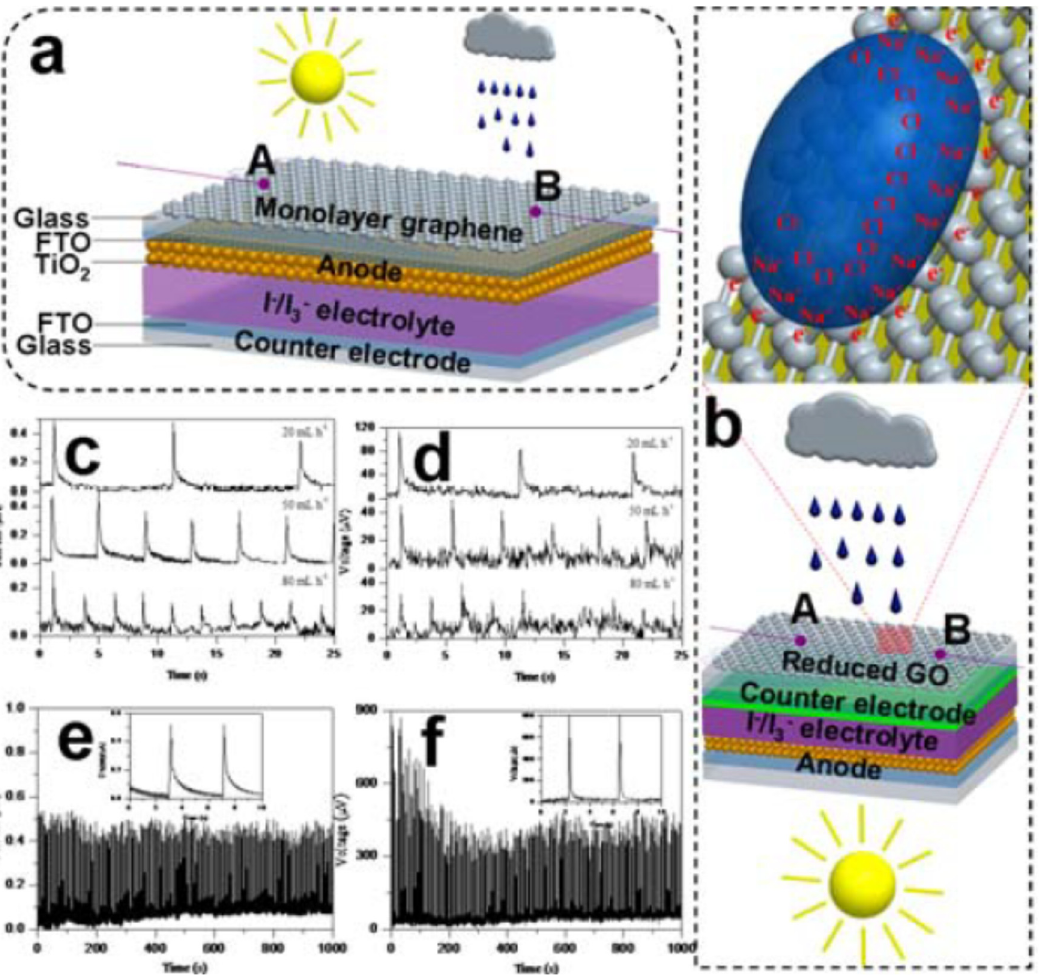
Figure 16. Schematic of the sun- and rain-enabled all-weather solar cell devices by covering ( a ) a monolayer graphene film on the top surface of photoanode as well as ( b ) reduced GO on back surface of a CE. The ( c ) current and ( d ) voltage outputs as well as long-term ( e ) current and ( f ) voltage stability by dropping simulated rain on b-type architecture. Reproduced with permission from [6] © 2021 WILEY-VCH Verlag Gmbh & Co. KGaA, Weinheim, Germany.